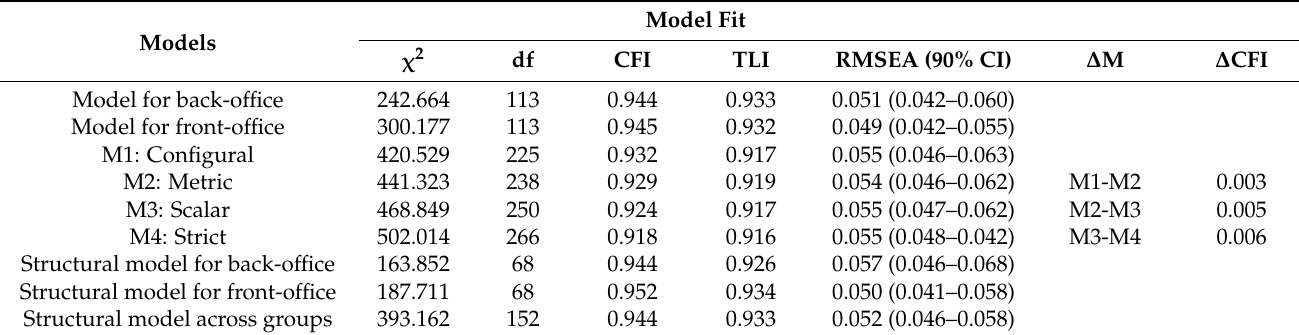
Table 2. Goodness-of-fit values of CFA models, multi-group test for measurement invariance, and the structural models testing the study hypotheses (ML estimation; back-office sample N = 436; front-office sample N =